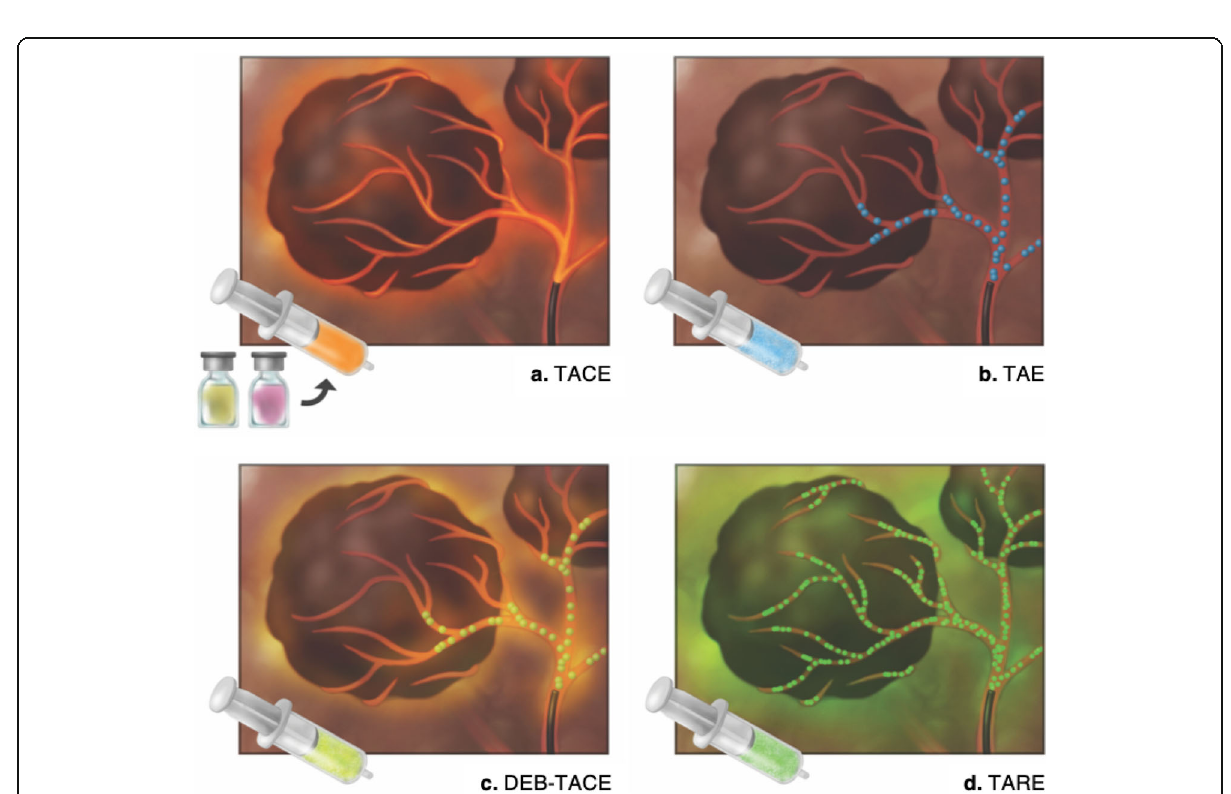
Fig. 18 Technically similar, transcatheter therapies greatly differ by the composition of the injection. a Transarterial chemoembolization (TACE) uses an emulsion of ethiodized oil and chemotherapy. b Transarterial (bland) embolization (TAE) relies solely on bland embolic material to treat the tumor. c Drug-eluting beads (DEB-TACE) are loaded with chemotherapeutic agent allowing prolonged delivery. d Transarterial radioembolization (TARE) delivers β -emitting microspheres. Note the greater diffusion of administered agents in the tumors with TARE compared to other transcatheter